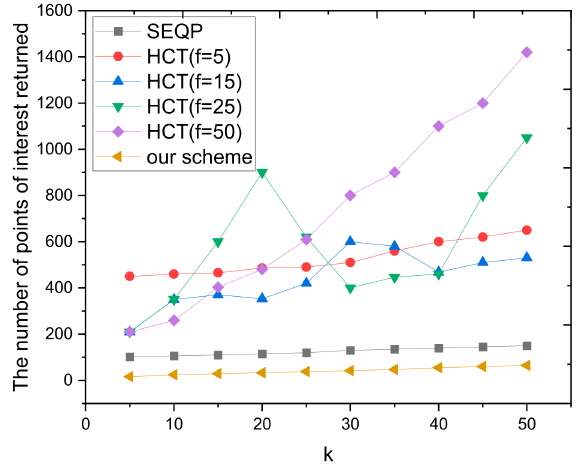
Figure 9. The number of points of interest returned under different requirements in real data.